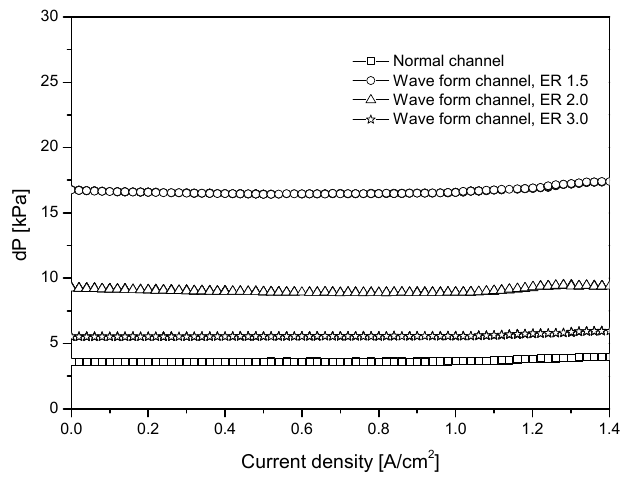
Figure 9. Unit cell difference curve in the normal channel and wave form channel, according to the variation in ER.